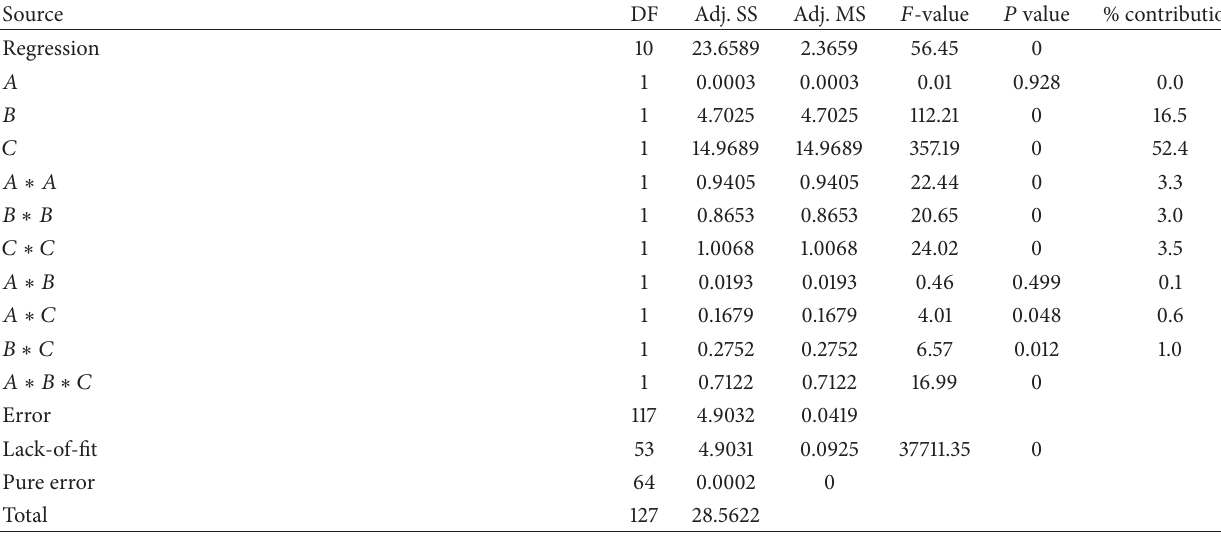
Table 5: ANOVA for 𝑅 𝑡